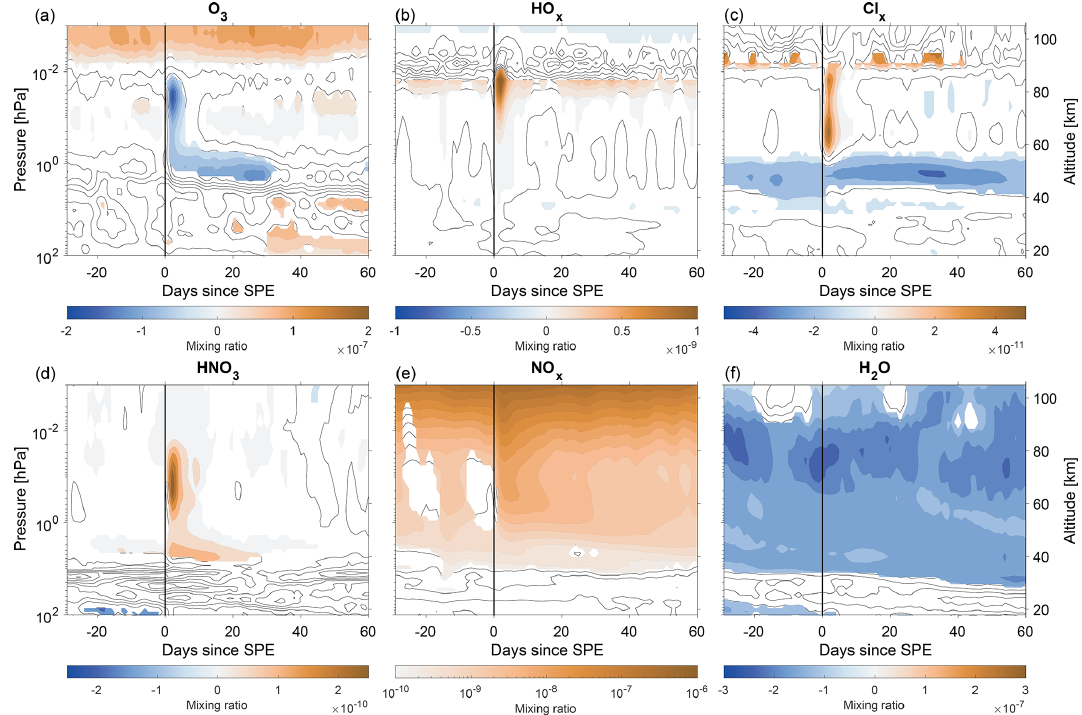
Figure 5. Area-weighted southern polar cap averages (latitude > 60 ◦ S) of composite means of (cid:100) WD for O 3 , HO x , Cl x , HNO 3 , NO x and H 2 O. The x axis shows the number of days before and after the event (day 0, solid black line) and the y axis pressure levels in the model (hPa, a, d ) and approximate altitude (km, c, f ). Note that the color scale for NO x panel is logarithmic, and all contours shown in that panel indicate positive